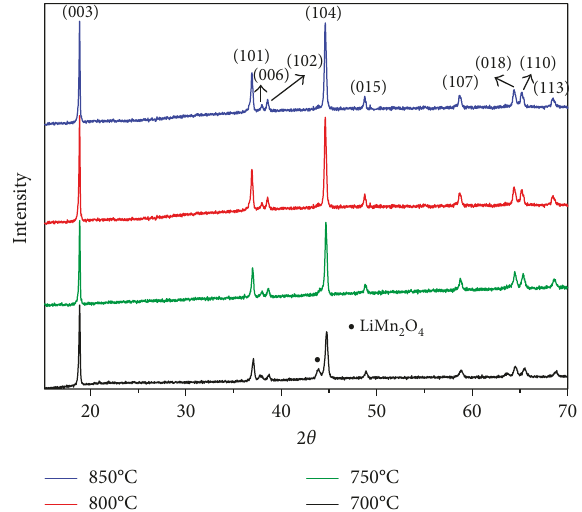
Figure 3: XRD patterns of products prepared at various temperatures.